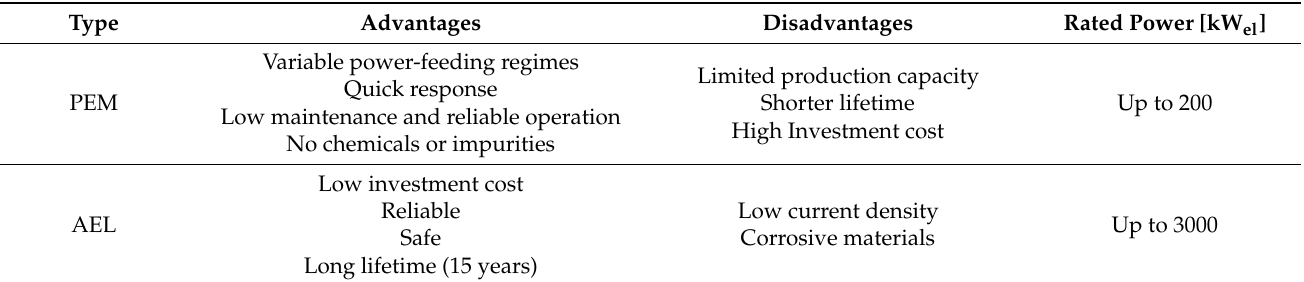
Table 4. Comparison between PEM and AEL electrolyzers